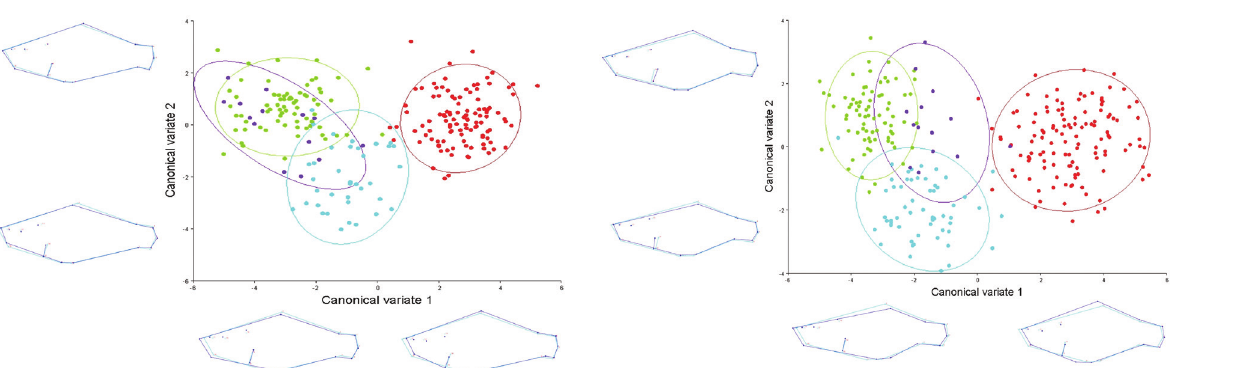
Figure 4. Canonical variate analysis of the morphometry of males. Red dots = A. bellottii , Purple dots A. univentripinnis , Green dots = A. melanoorus , Skyblue dots = A. queguay . Defor - mation (dark blue line) from consensus configuration (sky blue line) associated to each canonical axis.